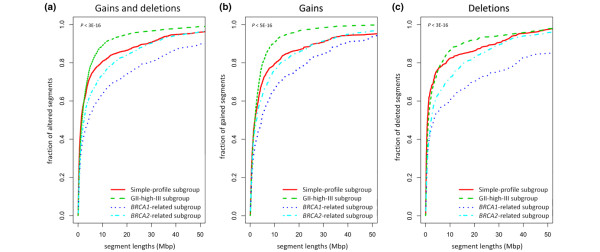
Quantitative analysis of the observed genome architecture patterns. Empirical cumulative distribution curves for segment lengths within each of the four identified subgroups were examined. The distribution of segment lengths for each of the identified subgroups are shown for all segments (a) altered in copy number, (b) gained in copy number and (c) deleted in copy number. The P-values in each of these comparisons were highly significant (P < 10-15) determined through a Kruskal-Wallis hypothesis test.